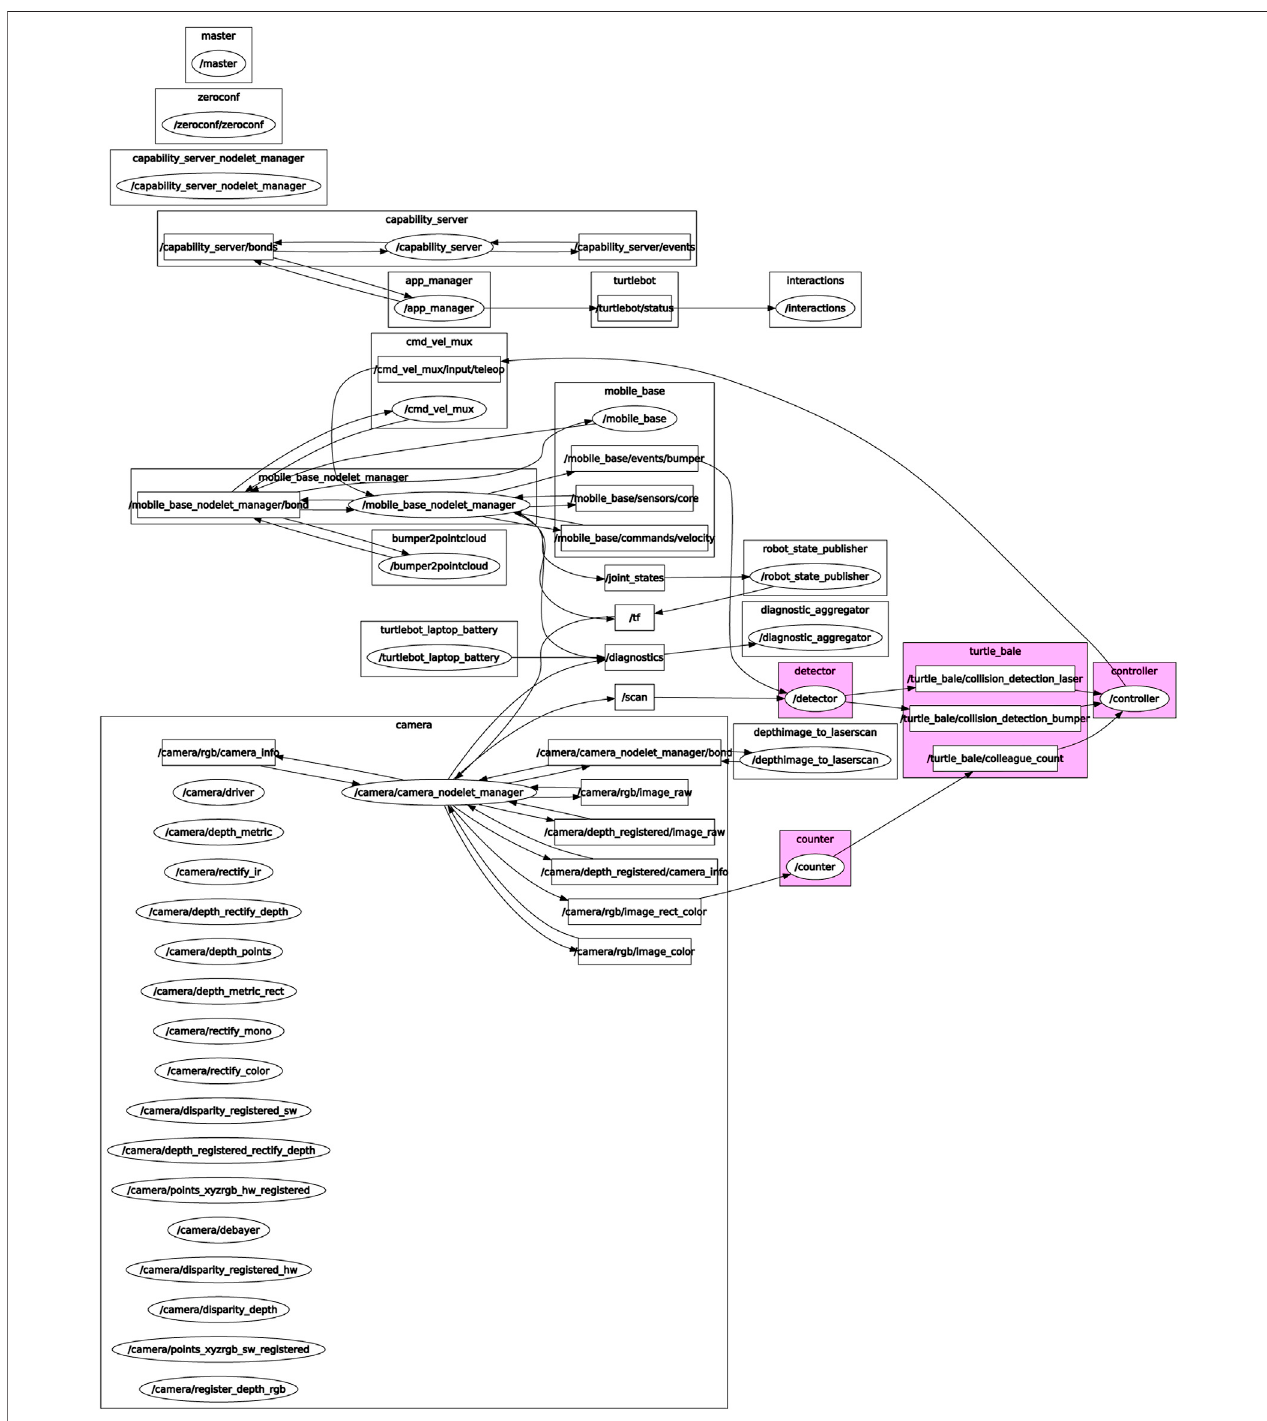
FIGURE8| OurTurtlebotapplication ’ sROSgraph.Theapplicationtopicsandnodeswrittenbyusarehighlighted,whiletherestofthegraphwasmadeavailableto us by the ROS community.